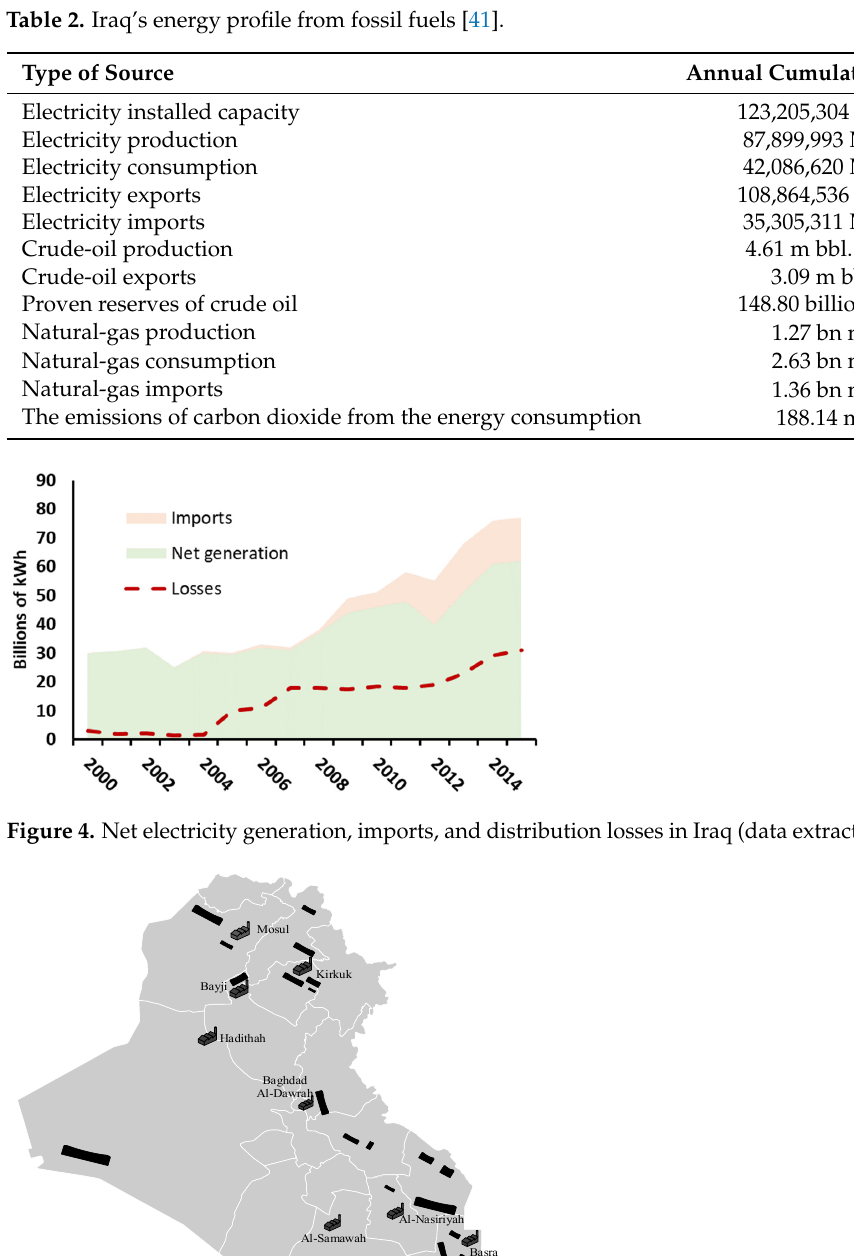
Figure 3. Number of energy stations and their generation rates in Iraq (data extracted from [28]).